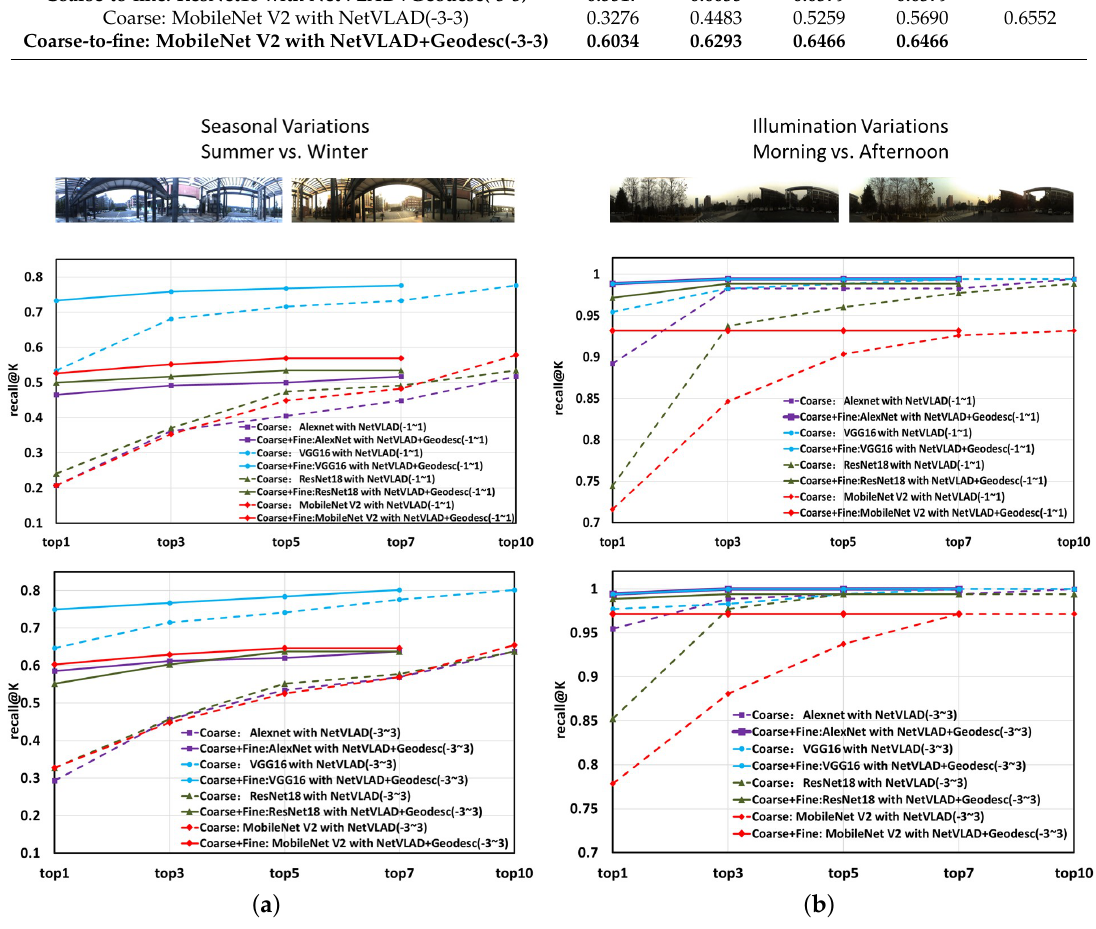
Figure 9. Line chart of matching results on Chengyuan dataset. ( a ) subset 2 as query and subset 1 as database; ( b ) subset 3 as query and subset 1 as query. (Coarse means the coarse stage, Coarse+Fine means combination of the coarse stage and the fine stage. − 1–1 means 1 image before and after the ground truth are setting as accurate localization, − 3–3 means 3 images before and after the ground truth are setting as accurate